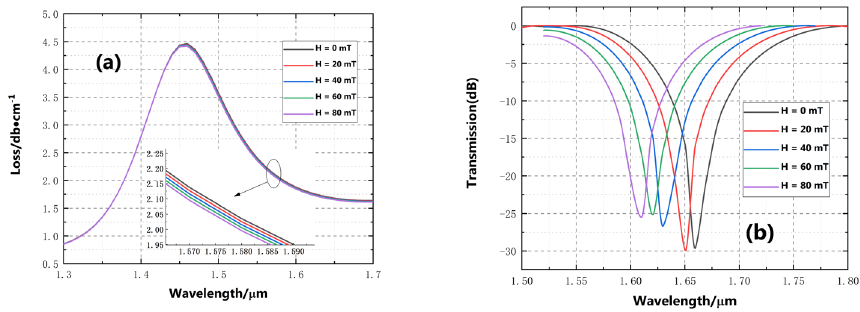
Figure 7. The loss spectra ( a ) and transmission spectra ( b ) under different temperatures for the op- timized sensor, H = 0 mT.